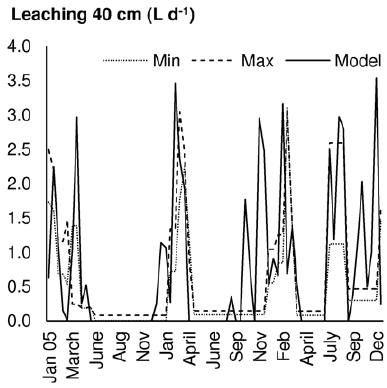
Figure 5. Leaching of water from soil layer 2. Model compared to measurement for CTR, MSW and GSW treatments. Model is average of all predictions, min and max is minimum and maximum lysimeter measurements, MSW(I) and CTR(II), respectively.